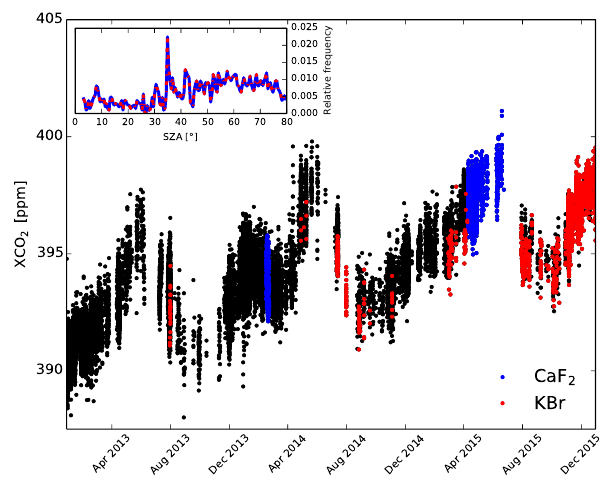
Figure 2. Time series of the X CO data set from the Altzomoni site 2 (black points) with the elements of the KBr (red points) and the CaF 2 (blue points) ensembles. The inset plot show the SZA distri- bution of both